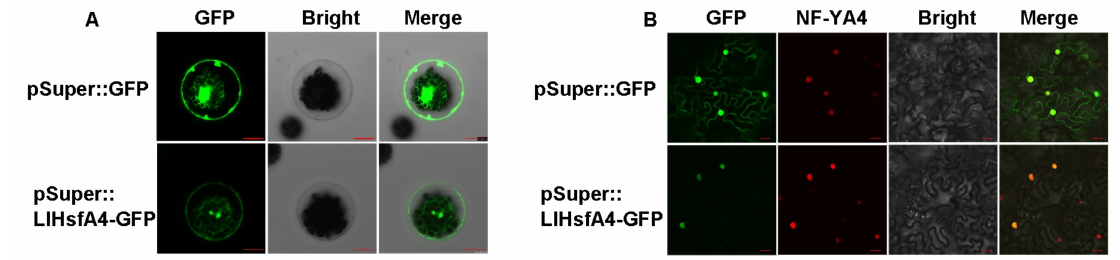
Figure 4. Subcellular localization of LlHsfA4. LlHsfA4-eGFP fusion protein was localized in the nucleus of a lily mesophyll protoplast ( A ) and N. benthamiana ( B ). Bar: 20 µ